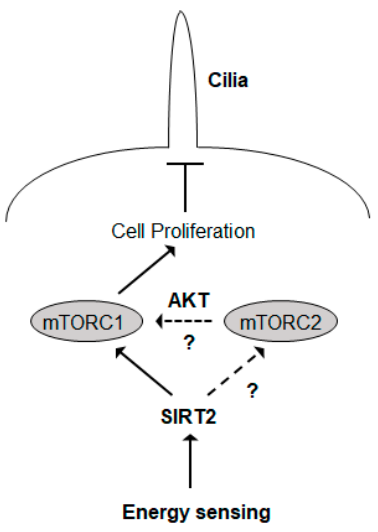
Figure 6. SIRT2 is a critical hub that links nutrient signaling and primary cilia formation. SIRT2 senses growth factor status and controls mTOR signaling. We propose that SIRT2 regulates mainly the mTORC1 complex (SIRT2-mediated regulation of mTORC2 requires further investigation). Activation of mTOR signaling promotes cell proliferation. By contrast, SIRT2 suppression inactivates mTOR signaling and arrests cells at G0 / G1 phase. SIRT2 suppression promotes cilia formation after cell cycle arrest. Therefore, SIRT2 plays a role as a link between the energy milieu and ciliogenesis. The significance of black solid arrows was addressed in our study, but that of black dotted arrows needs further investigation.